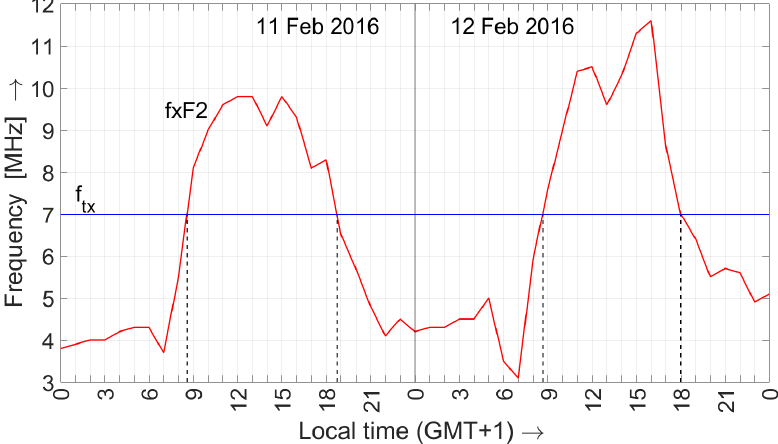
Figure 15. Peak plasma frequency of the ionosphere for the extraordinary wave ( fxF2 ) for the same two days, measured by the ionosonde of the Ebro Observatory, located at 40.8° N, 0.5° E.